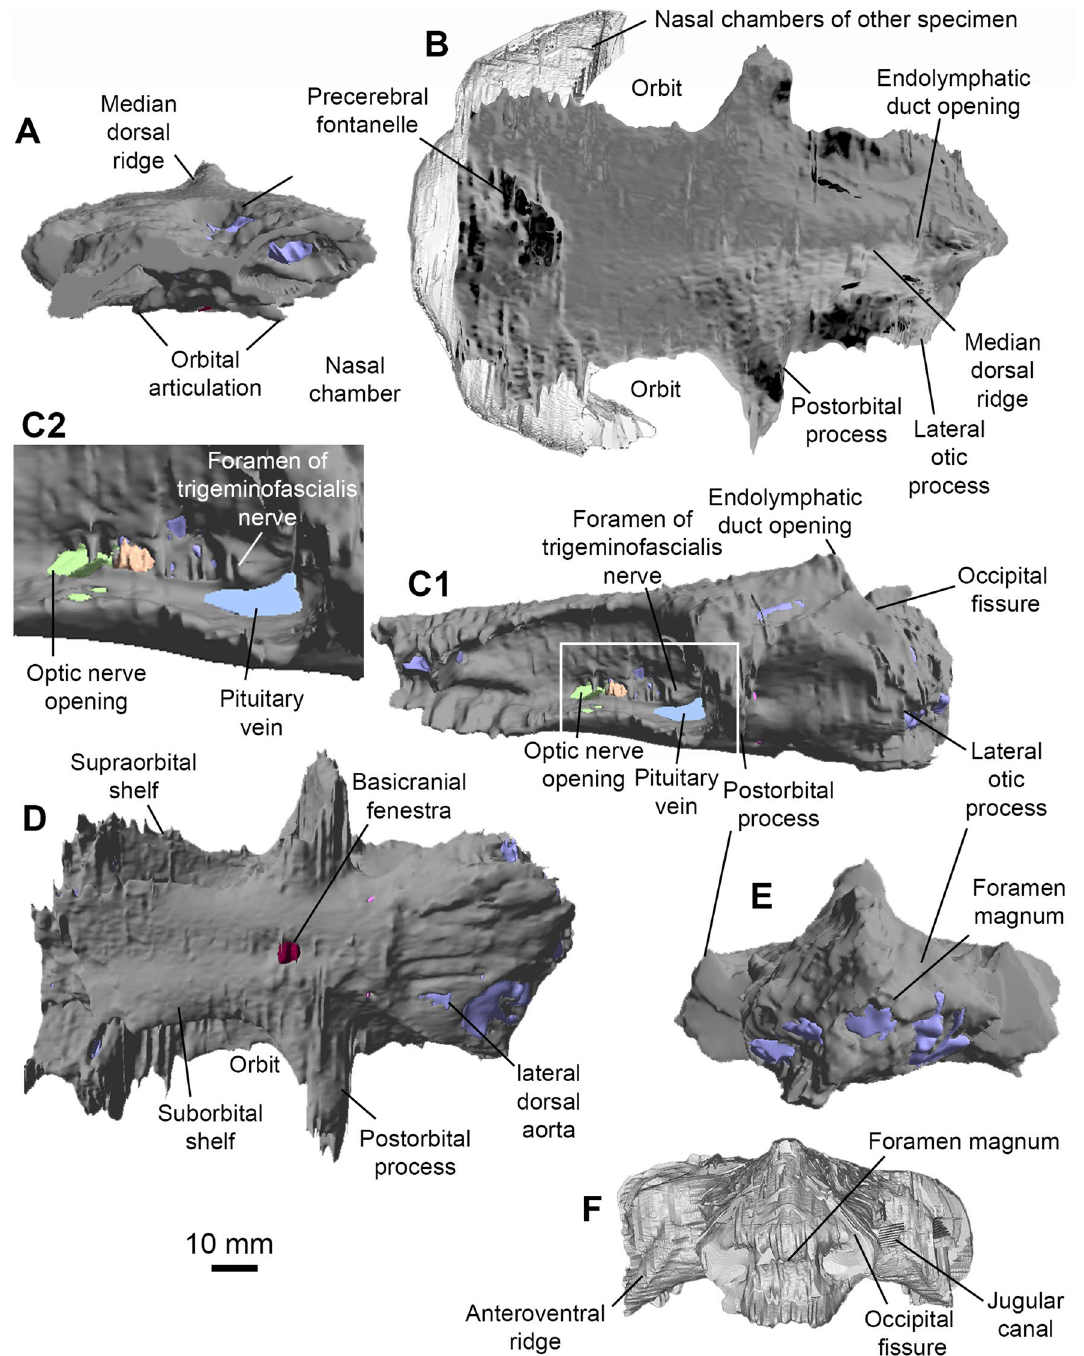
Fig. 4 Neurocranium of Maghriboselache mohamezanei n. gen. et sp. A to E holotype, AA.MEM.DS.12. A anterior, B dorsal (other specimen: PIMUZ A/I 5156), C left lateral (C2: detail of C1, marked by rectangle in C1), D ventral, and E posterior view. F PIMUZ A/I 5156, posterior